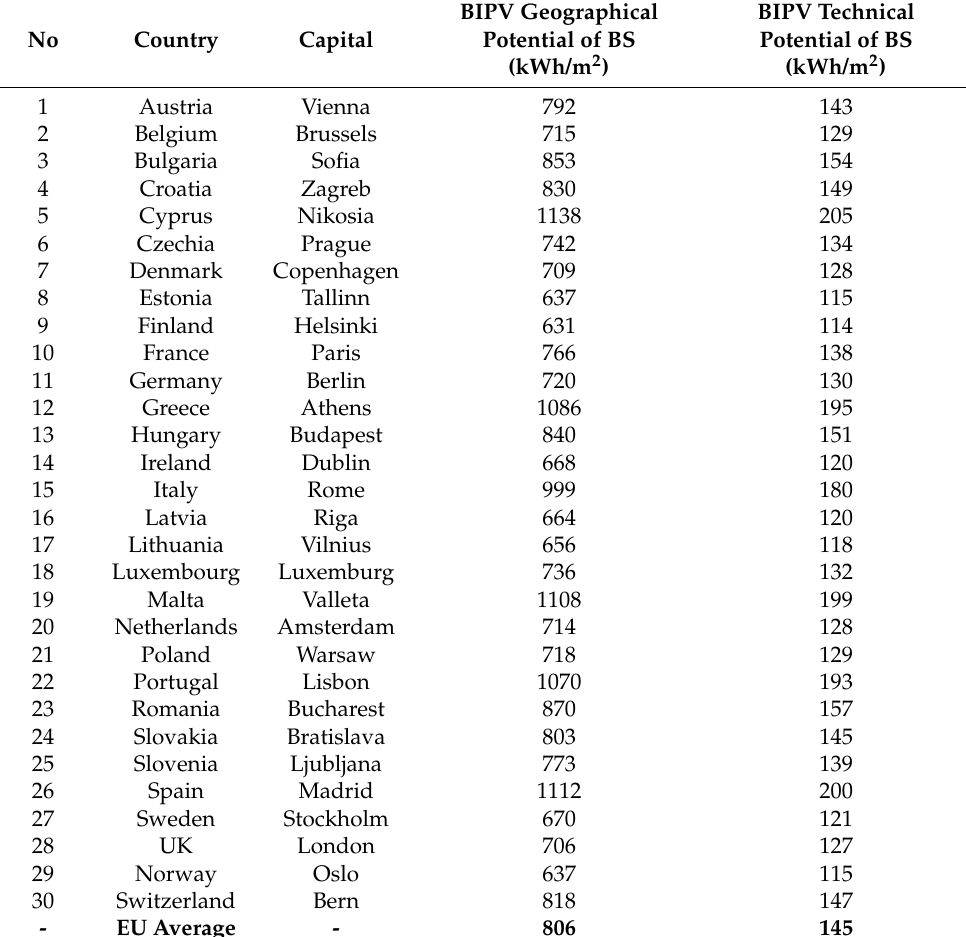
Table 2. The average annual geographical and technical potential of BS for BIPV systems in Europe.